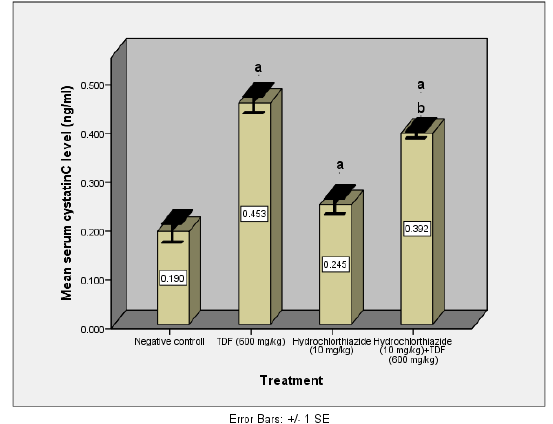
Figure 1. Effect of different treatments on cystatin C level in serum of rats' group.